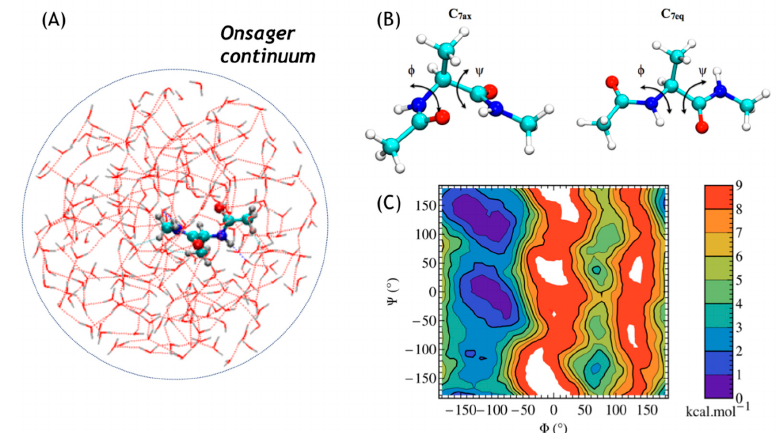
Figure 7. Free energy profiles for S N 2 reactions between CH 3 Cl and OH − (in black) or SH − (in